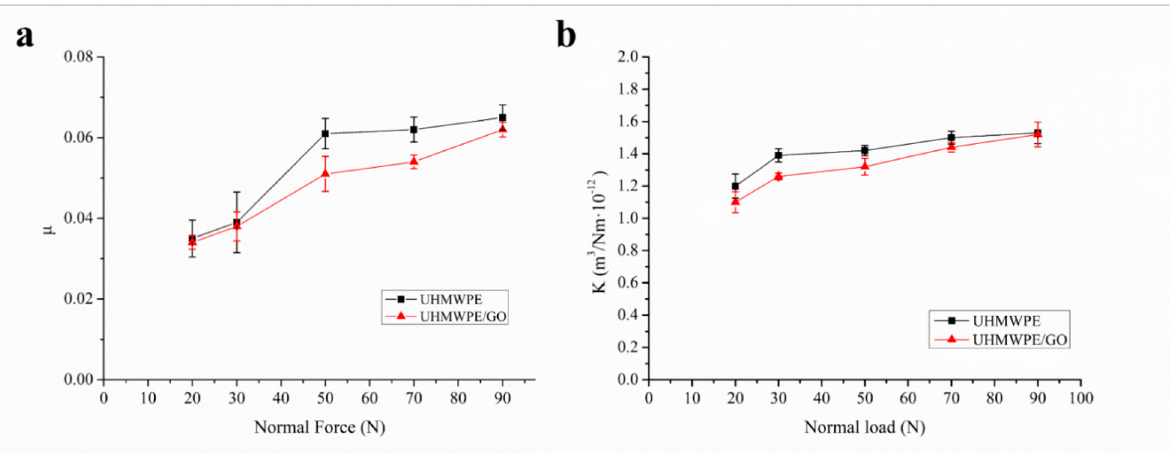
Figure 10. Effect of normal loads on the coefficient of friction and wear ratio of GO/UHMWPE composite material.